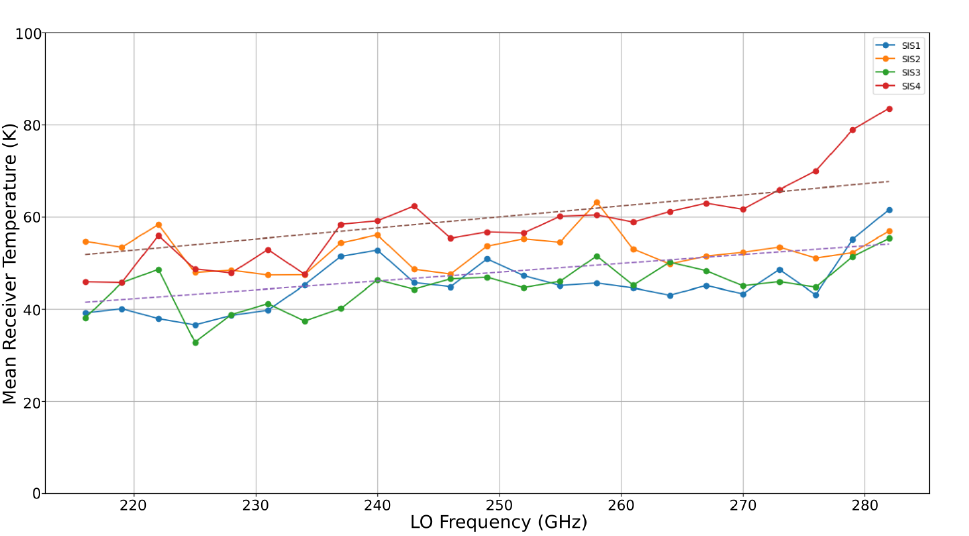
Figure 4. Mean noise temperature across an IF frequency range of 3–10 GHz, over an RF frequency range of 216–283 GHz for the 1mm receiver component of the dual-frequency receiver. The two dashed lines show the 4 × and 5 × theoretical quantum noise limits at each corresponding RF